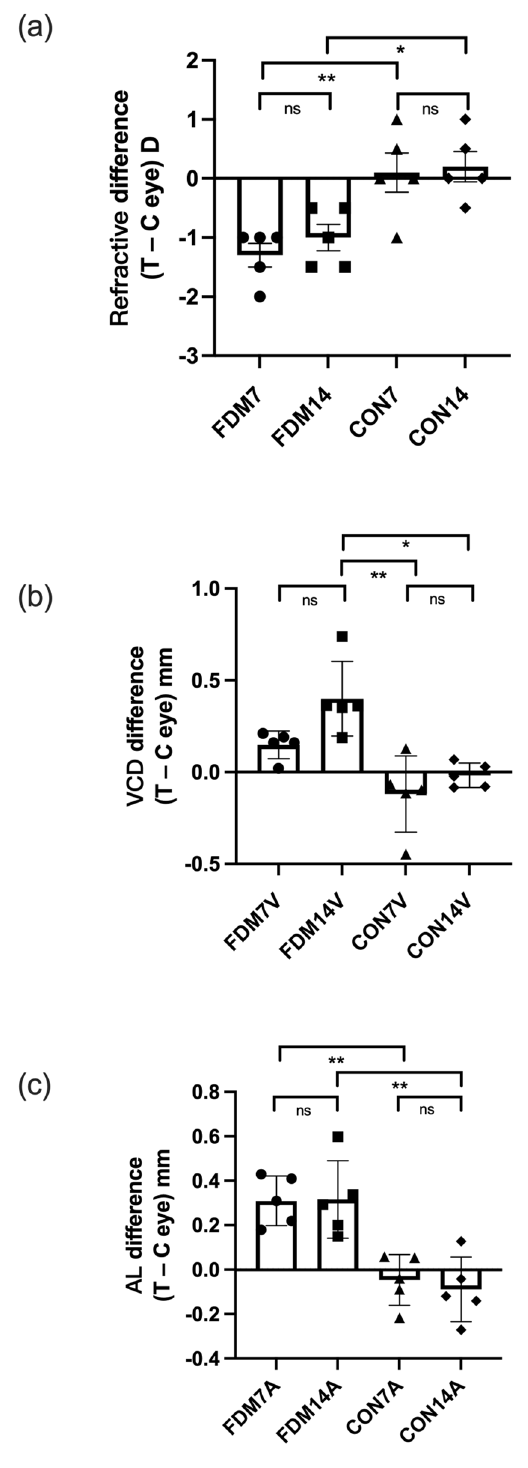
Figure 1. Differences in ocular refraction ( a ), vitreous chamber depth ( b ), and AL ( c ) between the treated eye and contralateral control eye (left and right eyes in the CON7 and CON14 groups) in the FDM and control groups. The three parameters indicated significant myopia in the FDM eyes compared with the CON7 and CON14 eyes. Values are shown as the mean ± standard error. * p < 0.05, ** p < 0.01. C, contralateral control eye; ns, not significant; T, treated eye; VCD, vitreous chamber depth.